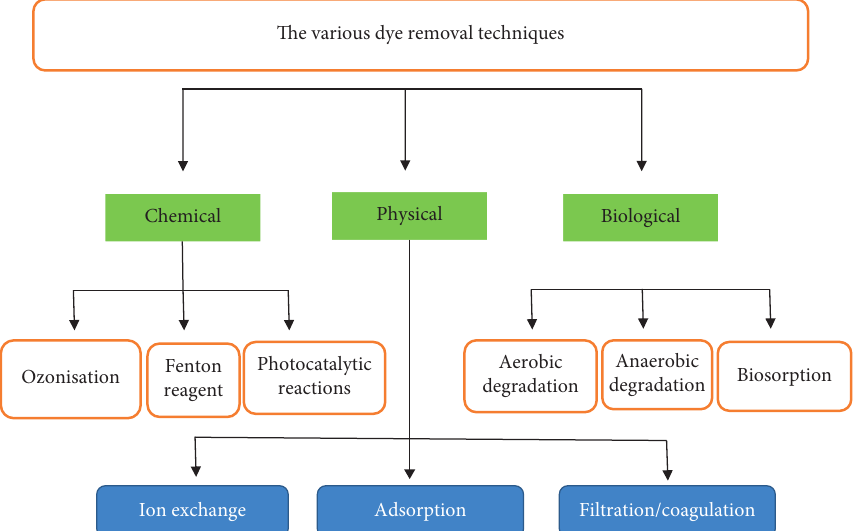
Figure 1: Classification of dye removal techniques. Techniques are classified as chemical, physical, and biological methods which are further classified into different